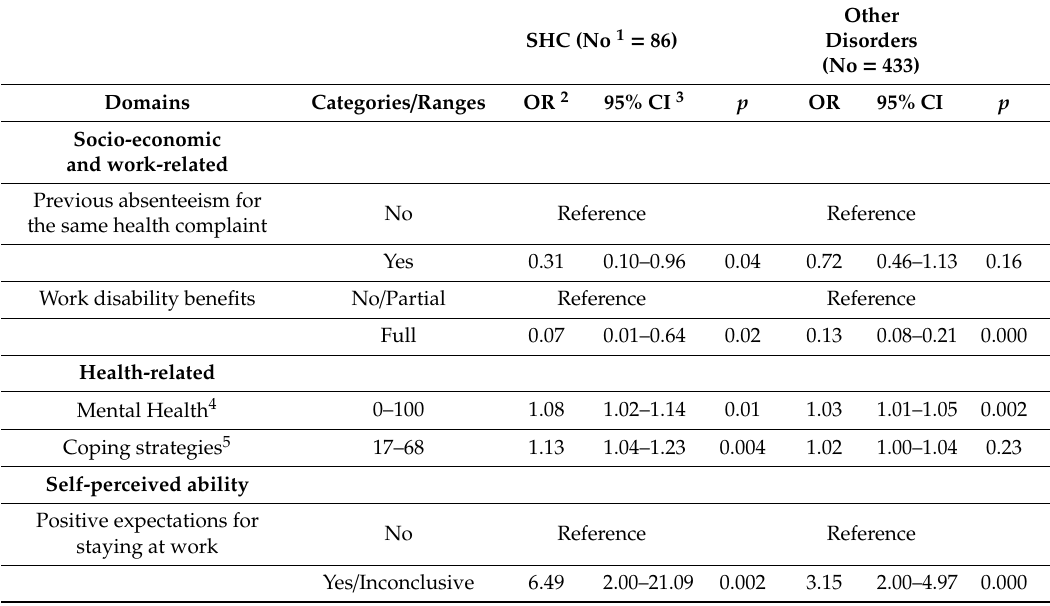
Table 4. Final model of all remaining predictors for staying at work for participants with subjective health complaints (SHC) and other disorders